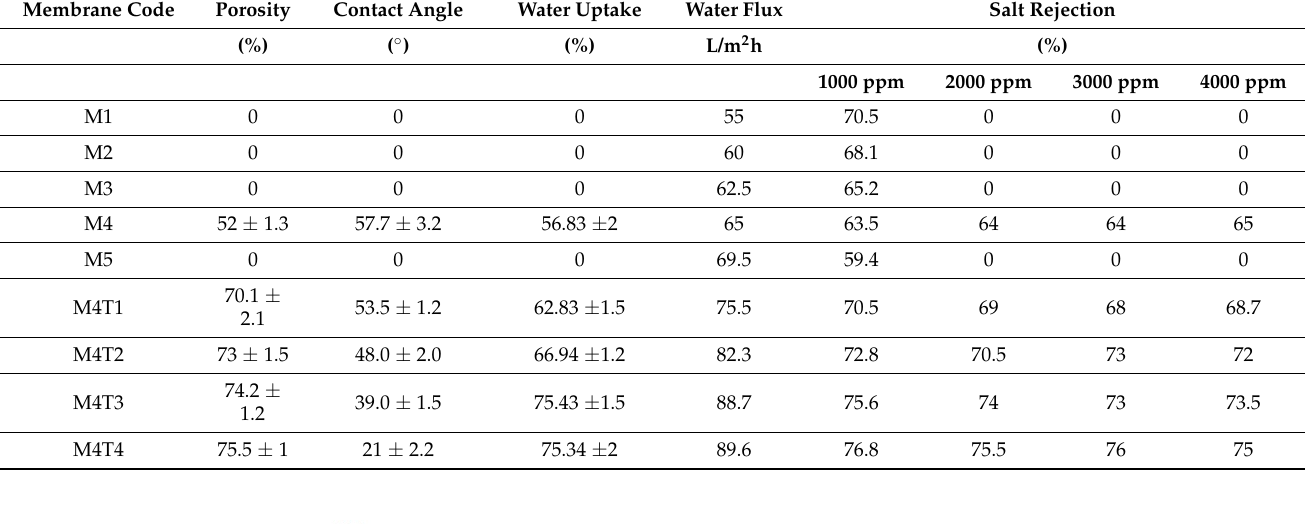
Figure 5. Pristine and nanocomposite membranes’ static water contact angle (average contact an- gles of samples are reported) and percent porosity. Table 2. TiO2/pore former effect on the performance of the pristine membrane and MMNMs.